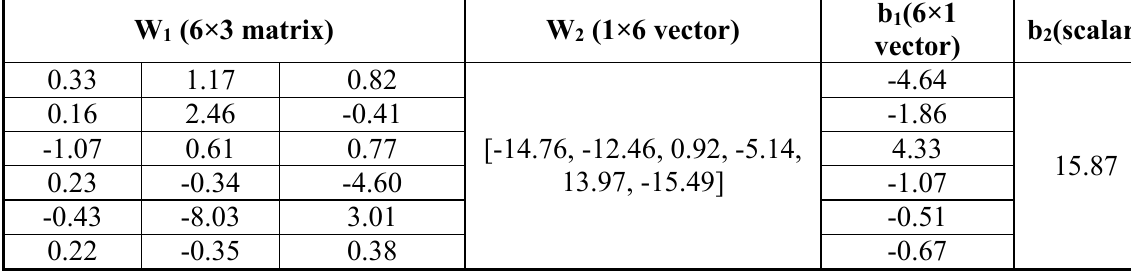
Figure 10. Experimental versus predicted values of percentage removal of Cr (VI). Table 5. Weights and biases of the neural networks.